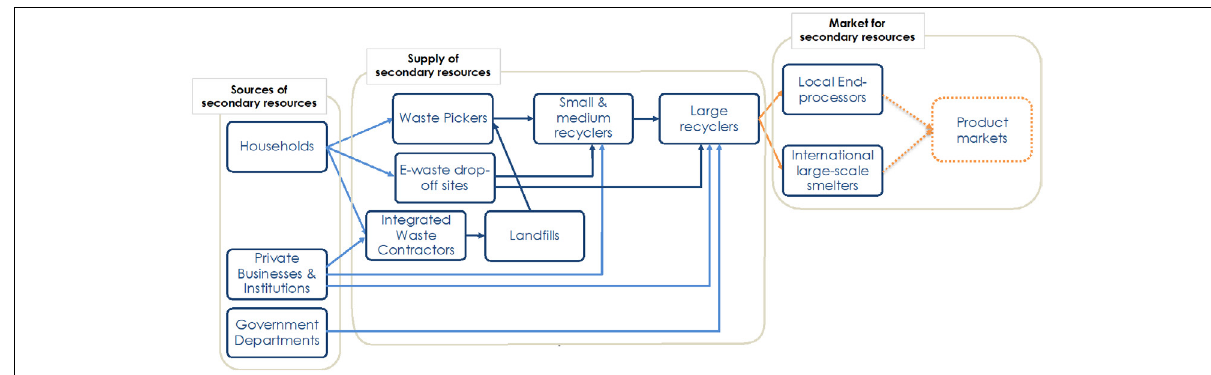
Figure 2: E-waste collection and recycling network in South Africa. 6